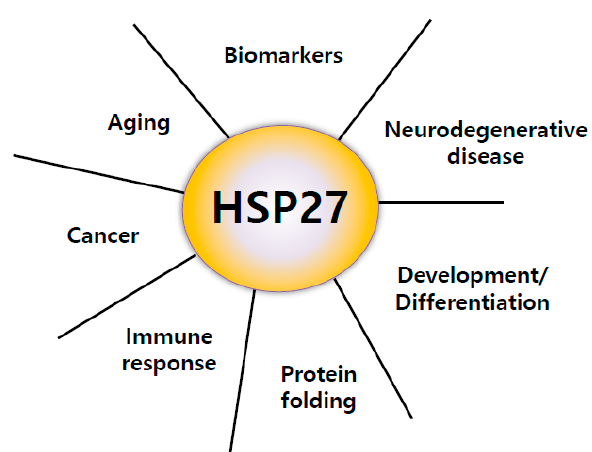
Figure 1. Major roles of heat shock protein 27 (HSP27). HSP27 has important functions, including protein folding regulation by chaperone activity, immune response, cancer promotion, inducing resistance to anticancer drugs, aging, biomarkers of several diseases, aggravation of neurodegenerative disease, development, and differentiation [5–8].